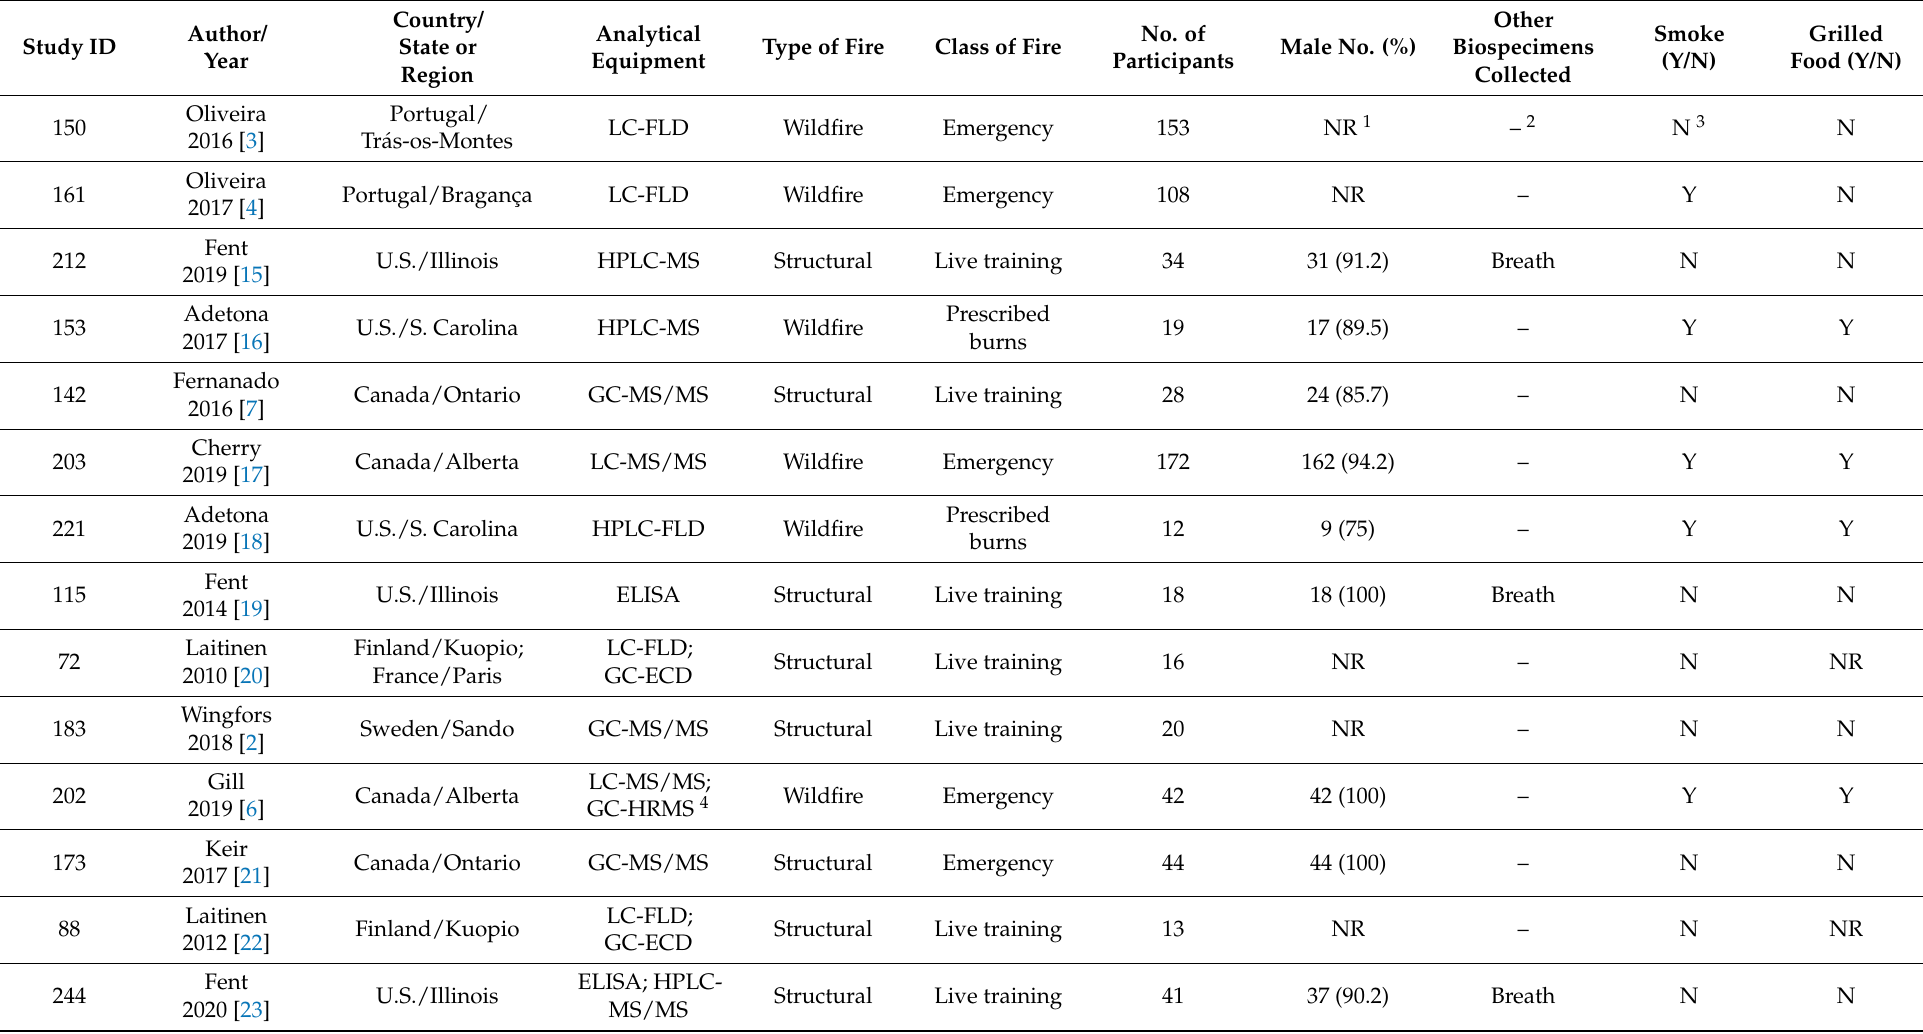
Table 1. Summary of study characteristics in evaluations of urinary OHPAH metabolites in